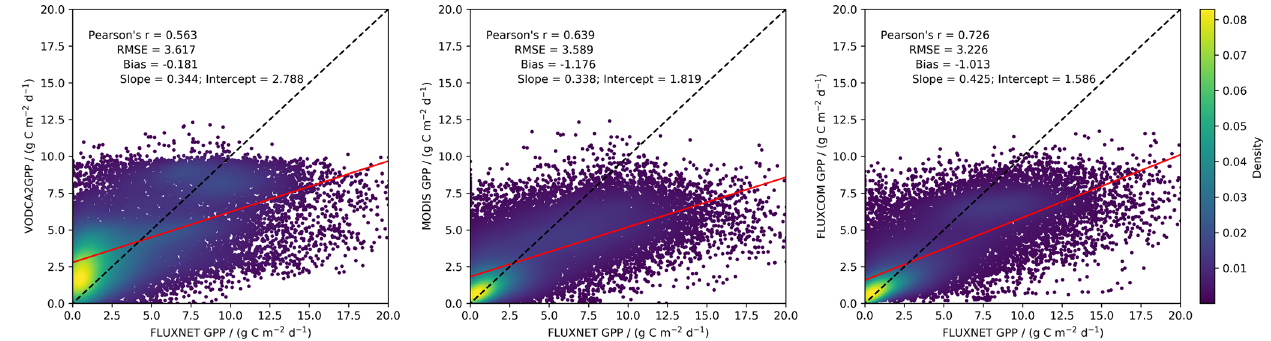
Figure 4. GPP from FLUXNET plotted against GPP from VODCA2GPP, MODIS, and FLUXCOM for the period 2002–2016 with 8d sampling.